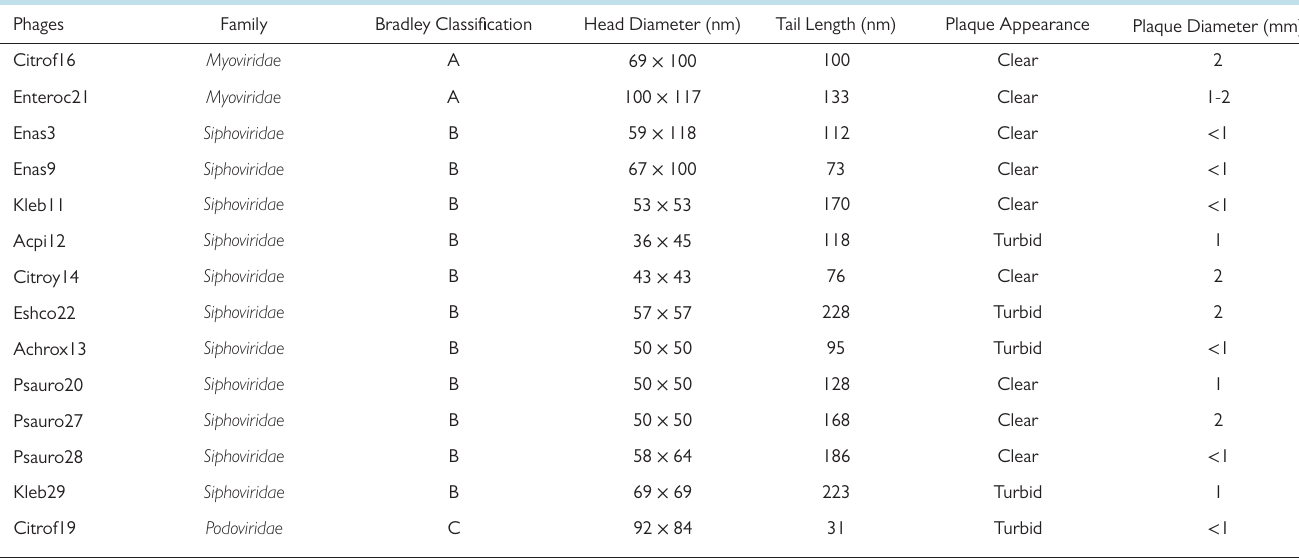
Table 3. General Characteristics of